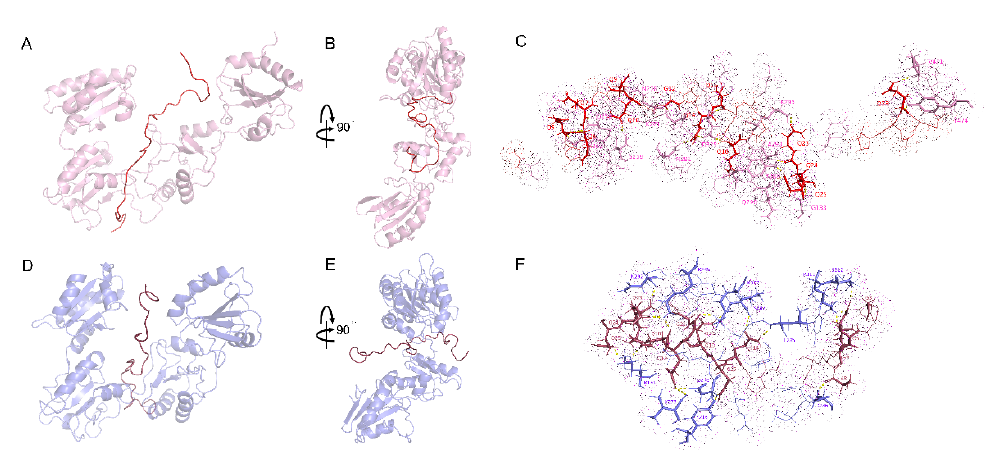
Figure 6. Interaction between DRS and wPDI O / R . ( A , B ) interaction between DRS and wPDI O ; cartoon representations of wPDI O (pink) and DRS (tv_red). ( C ) stick representations of amino acid residues involved in the interaction between wPDI O (pink) and DRS (red). ( D , E ) interaction between WRS and wPDI R cartoon representations of wPDI R (slate) and DRS (raspberry). ( F ) stick representations of amino acid residues involved in the interaction between wPDI R (slate) and DRS (raspberry). Dotted amino acid residues are involved in the hydrophobic interactions and the dotted line indicates hydrogen bonds.